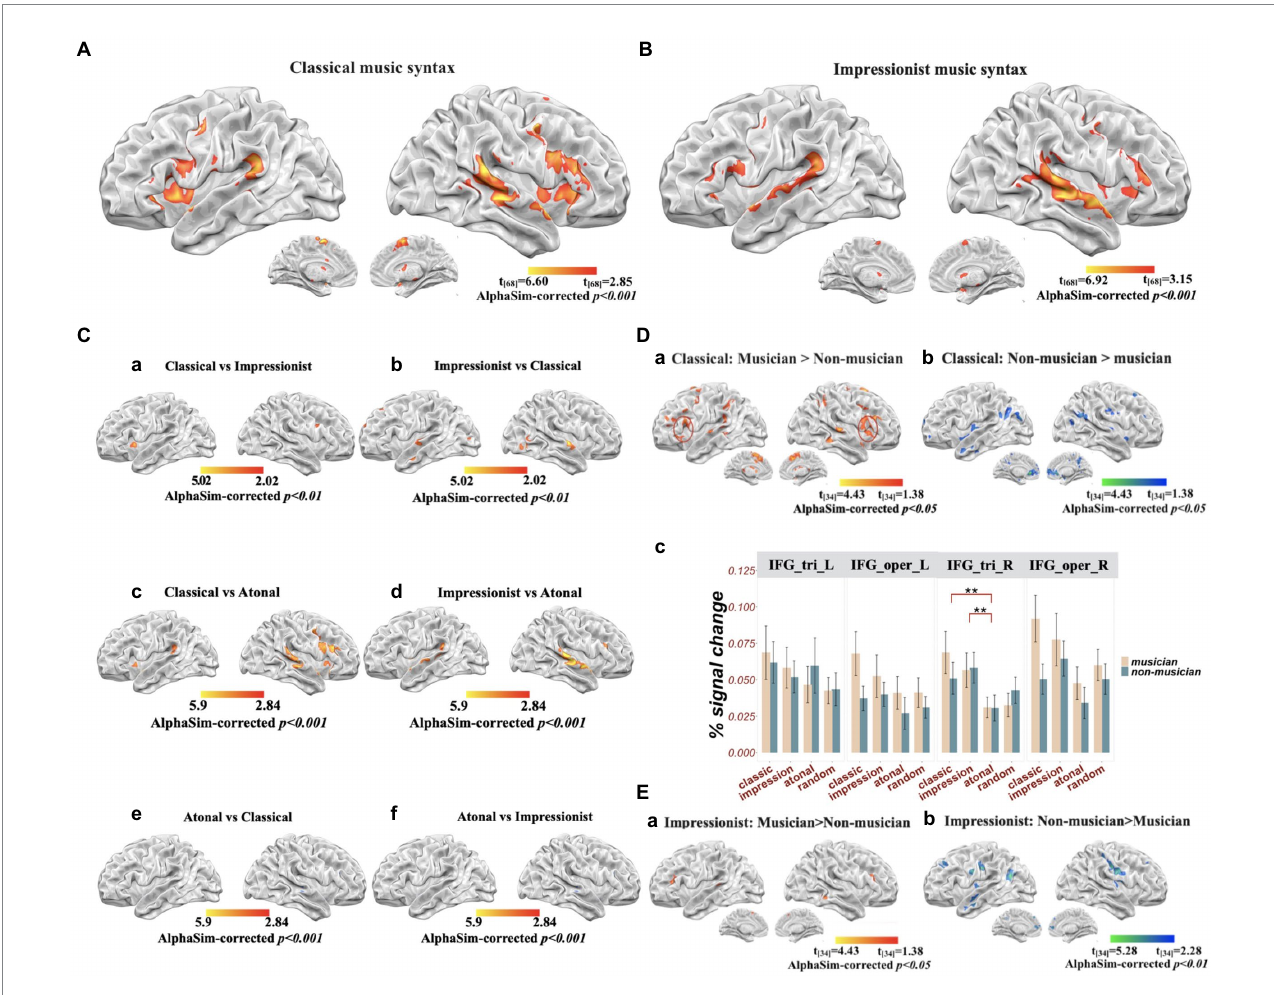
FIGURE 3 Brain activation for musical syntax processing (all results alphasim corrected at p < 0.001, unless otherwise stated). (A) Classical music compared to random notes; (B) impressionist music compared to random notes; (C) Comparisons among musical genres: (a) classical compared to impressionist music (alphasim corrected at p < 0.01 for illustration); (b) impressionist compared to classical music (alphasim corrected at p < 0.01 for illustration); (c) classical compared to atonal music; (d) impressionist compared to atonal music; (e) atonal compared to classical music; (f) atonal compared to impressionist music; (D) difference between groups for classical music: (a) musicians compared to non-musicians; (b) non-musicians compared to musicians; (c) percent signal change in left and right inferior frontal gyrus (IFG); (E) differences between groups for impressionist music: (a) musicians compared to non-musicians; (b) non-musicians compared to